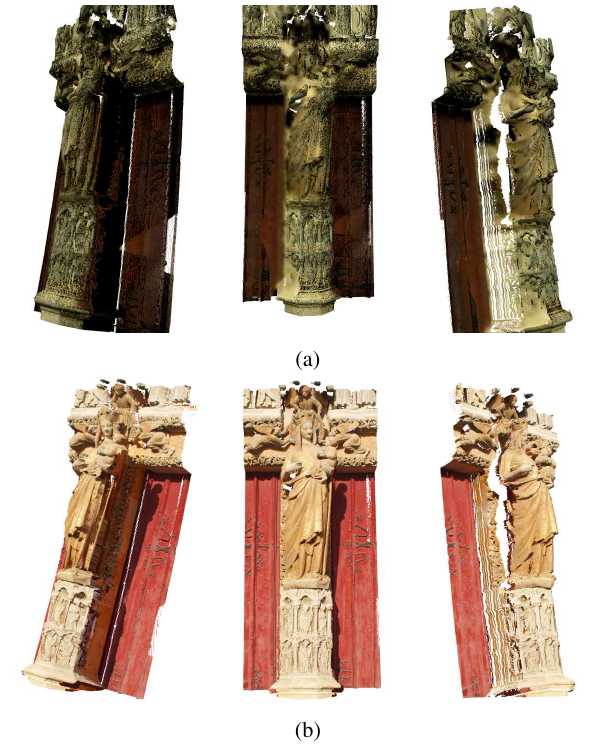
Figure 11: The Virgin Mary point cloud (a) before and (b) after our colorization.